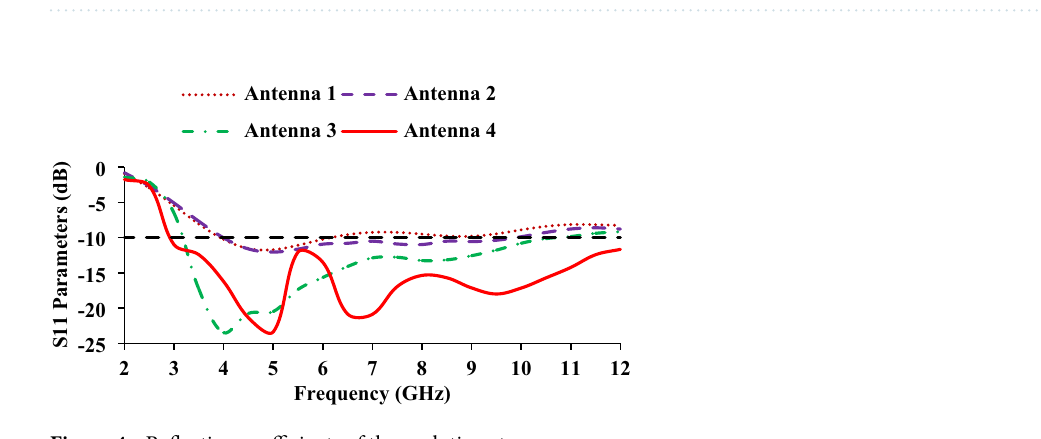
1 ) of the UWB frequency band